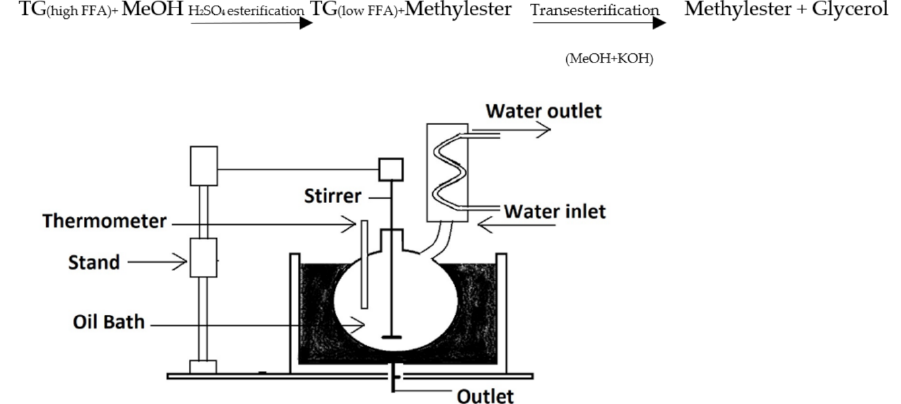
Figure 1. Schematic diagram of transesterification lab